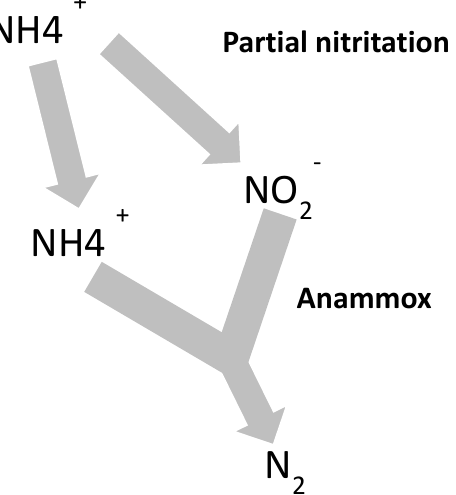
Figure 1. Nitrogen cycle in the partial nitritation/anammox